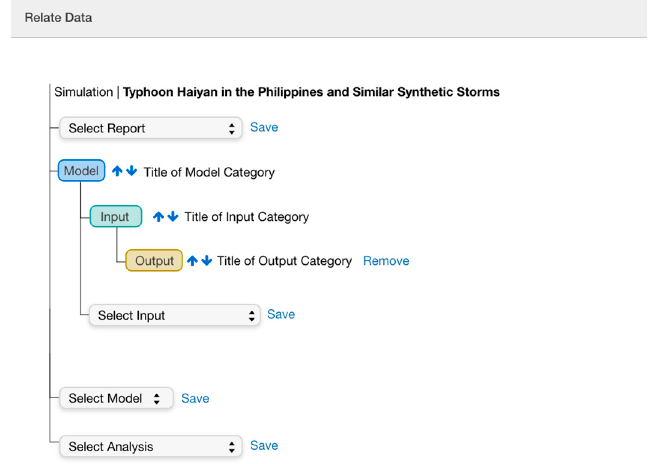
Figure 6. Relate data interactive step. Users relate categories of their project can make changes to the order of their models and adjacent